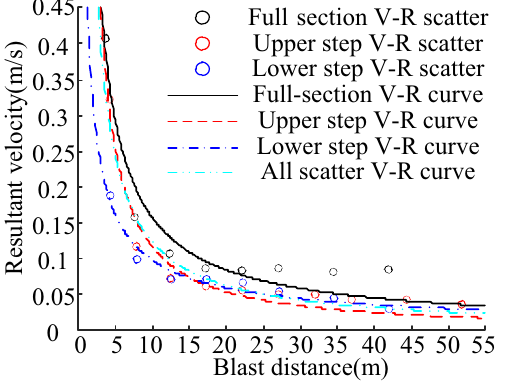
Figure 9. V–R scatter plot and fitting curve.